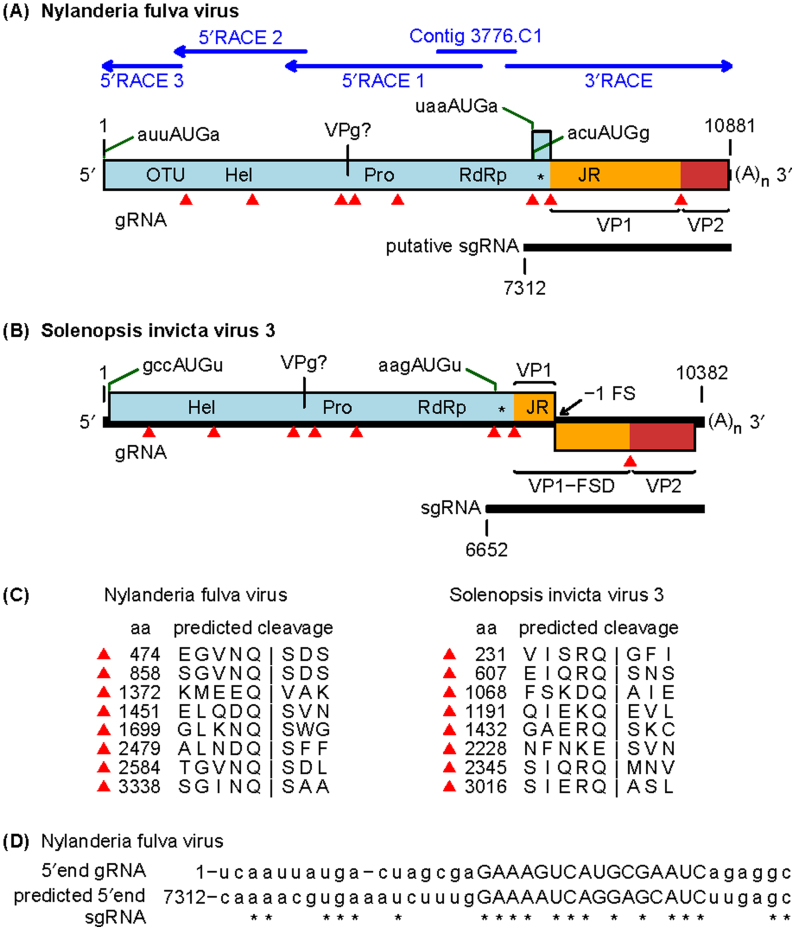
(A) NfV-1 genome organization and method of acquisition. The upper blue arrows represent the cloning strategy for acquiring the NfV-1 genome. Contig 3776.C1 was used as template for initial 5′ and 3′ RACE reactions. Positions of picorna-like helicase (Hel), protease (Pro) and RNA-dependent RNA polymerase (RdRp) protein domains are shown within the polyprotein ORF. Predicted ovarian tumor (OTU), picorna/calici-like jelly-roll fold capsid protein (JR) and dsRNA binding protein (*) domains are also indicated. Potential virus protease cleavage sites are indicated with red triangles. The sequence upstream of Pro is likely to correspond to VPg. A putative sgRNA is indicated. Initiation at the first AUG (poor context) on the sgRNA would lead to translation of a short overlapping ORF while initiation at the second AUG (strong context) would lead to translation of the dsRBP domain and capsid proteins. VP1 (orange) and VP2 (red) are annotated based on analogy with the mapped structural proteins of SINV-3. (B) SINV-3 genome organization and potential cleavage sites. (C) Sequences at the potential cleavage sites in NfV-1 and SINV-3. (D) Comparison of the 5′ terminal sequences of the NfV-1 gRNA and putative sgRNA.